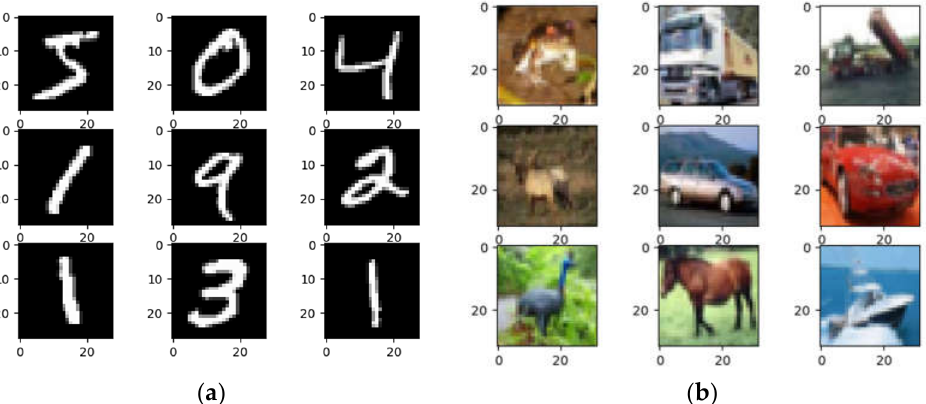
Figure 3. Sample images from benchmark datasets. ( a ) Sample images from MNIST dataset; ( b ) Sample images from CIFAR-10 dataset.